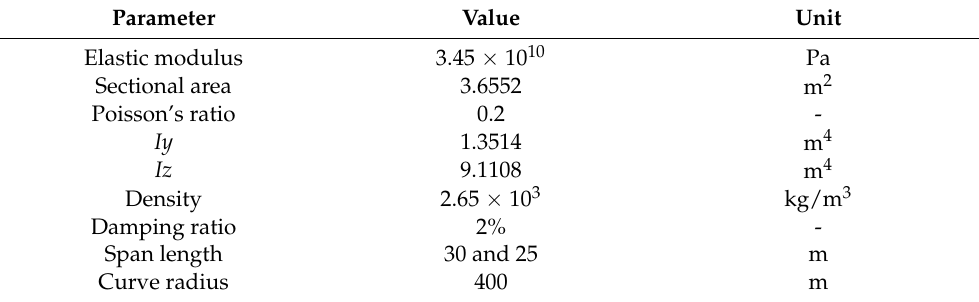
Table 1. Bridge parameters.